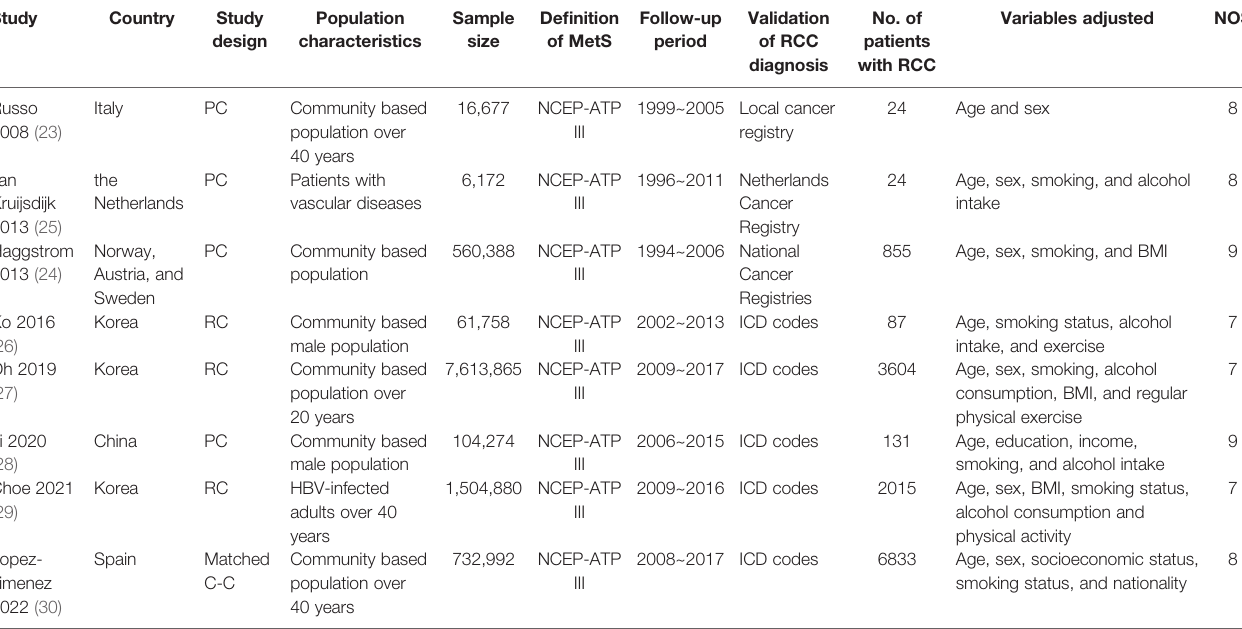
TABLE 1 | Characteristics of the included